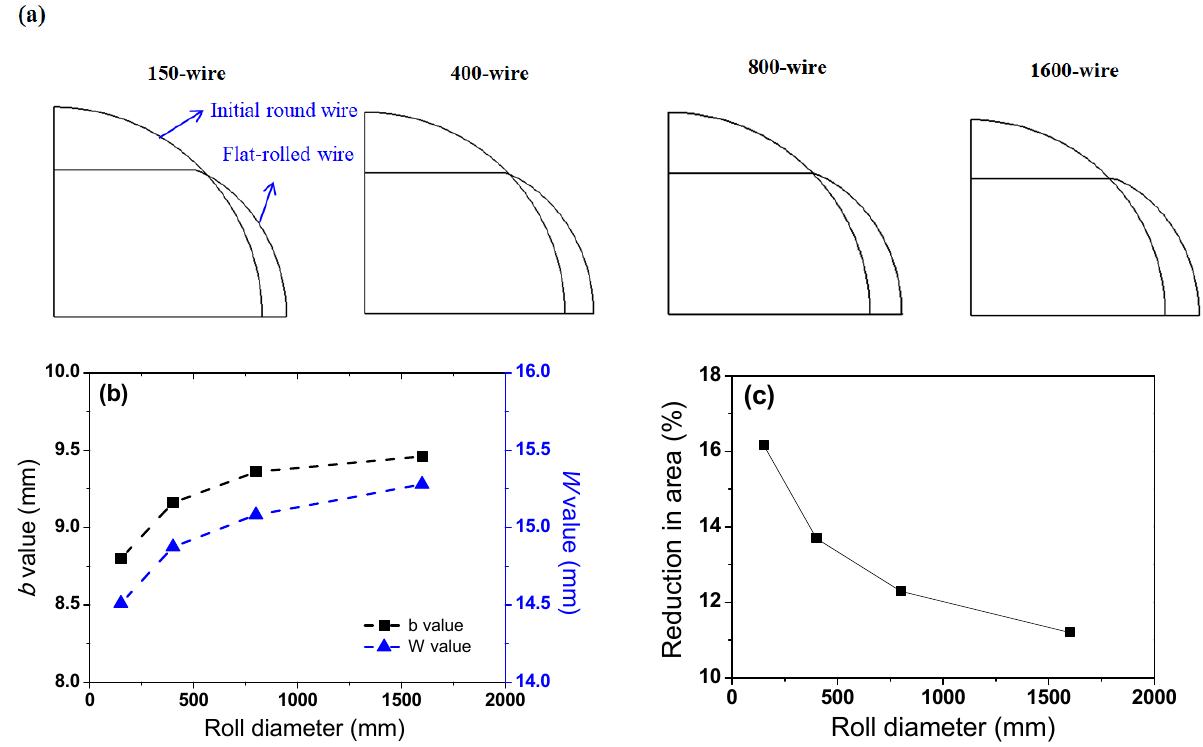
Figure 7. Comparison of ( a ) shape change, ( b ) b and W , and ( c ) R A against roll diameter.